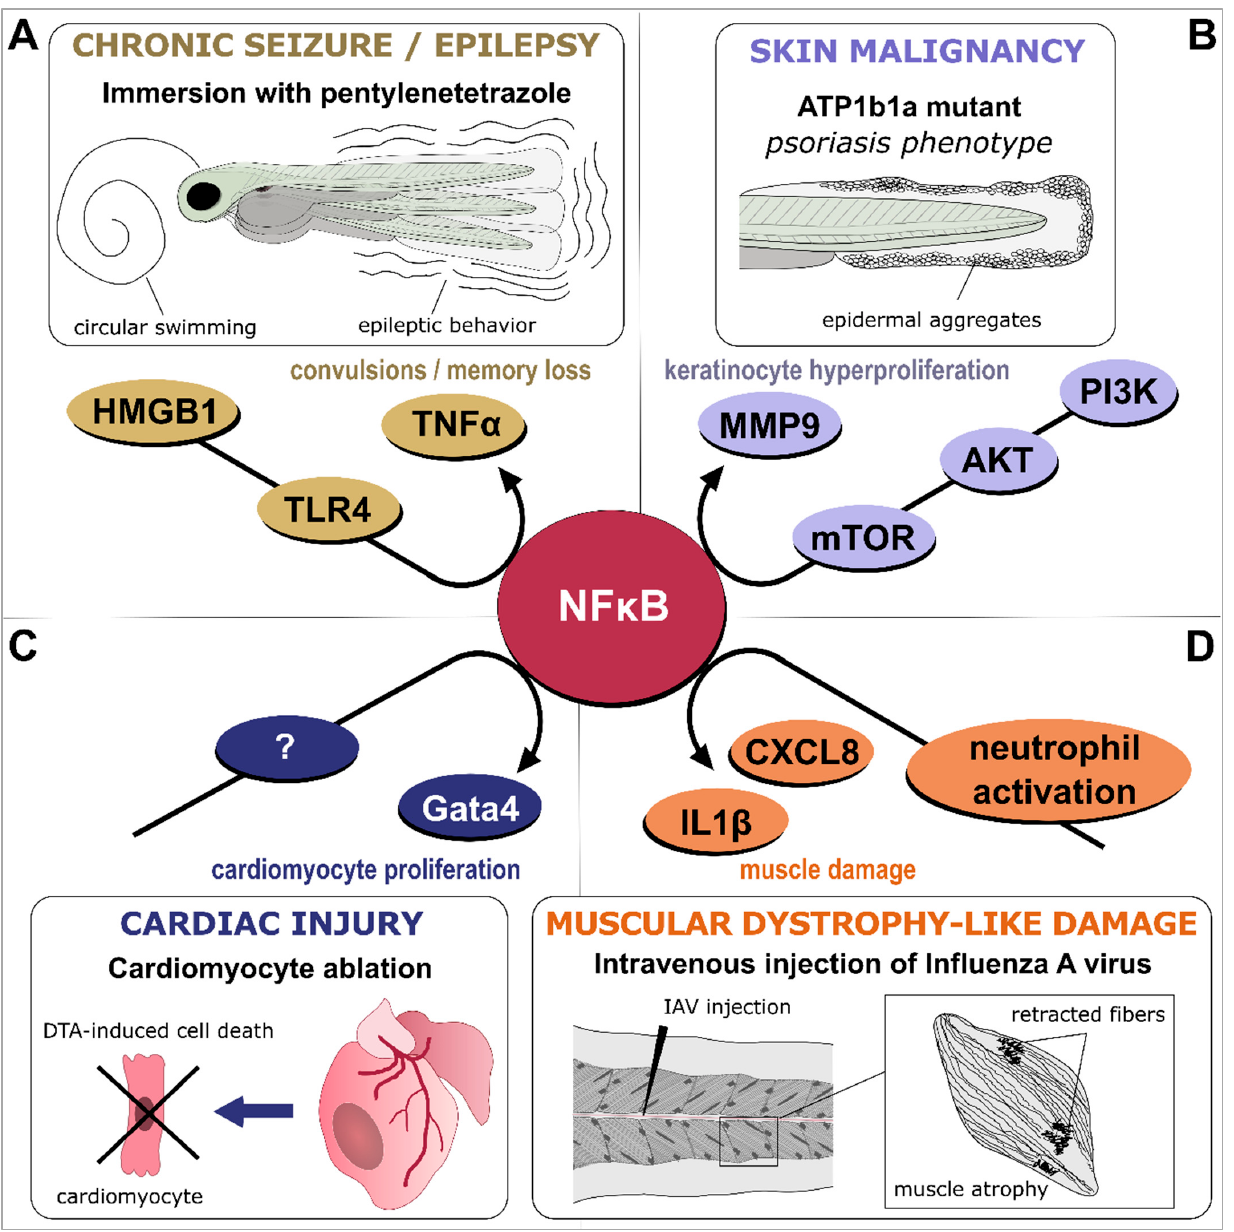
Figure 3. NF κ B-dependent signaling as a central hub in inflammation. Various models of inflammatory-driven pathologies generated in larvae or adult zebrafish have identified NF κ B signal- ing as part of the disease onset, progression, or recovery process. ( A ) . In an adult model of epileptic seizure induced by pentylenetetrazole, the HMGB1/TLR4/NF κ B pathway generates deleterious inflammation that results in a convulsive behavior [310]. ( B ) . In larvae, atp1b1a mutation results in psoriasis-like phenotype and skin malignancy, through activation of the PI3K-AKT-mTORC1- NF κ B-MMP9 pathway, which promotes keratinocytes overgrowth and invasiveness of epidermal layers [314]. ( C ) . In contrast to these deleterious effects, NF κ B pro-inflammatory signaling is required for cardiac regeneration as exemplified in an adult model of genetic cardiomyocyte ablation where NF κ B-dependent upregulation of gata4 -controled genes permits cardiomyocyte proliferation and epicardial infiltration [315]. ( D ) . Infection of zebrafish larvae by Influenza A virus (IAV) induces a neutrophil-dependent activation of NF κ B in skeletal muscles, upregulating pro-inflammatory cy- tokines such as IL1 β and CXCL8 and generating sustained muscle damage that mimics Duchenne muscular dystrophy